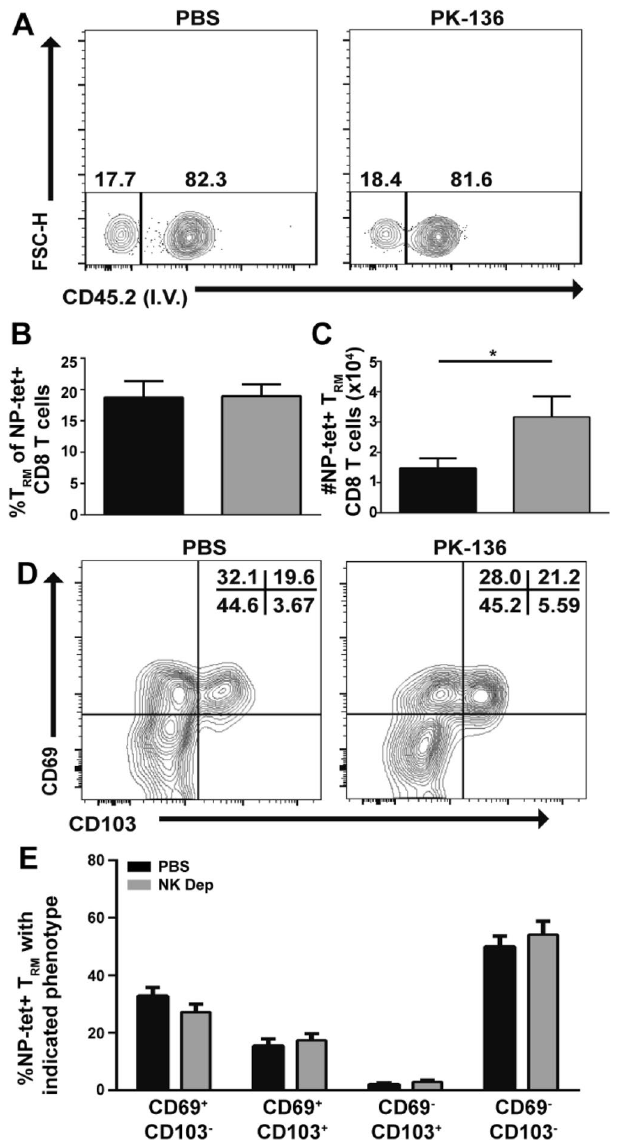
Figure 2. NK depletion enhances the development of lung T RM following influenza infection. (A) C57BL/6 mice were infected with 10 3 PFU x31, administered anti-NK depleting antibody at −1, 1, and 3 dpi and rested for 45 days. T RM were identified as cells which did not positively stain with an anti-CD45 administered i.v. 3 min prior to euthanasia, previously gated on single cells, lymphocytes, CD8 + CD44 + NP-tet + cells. The frequency (B), and number (C) of NP-tet + T RM CD8 + T cells ± SEM recovered from the lung of NK depleted (grey) and sufficient (black) mice are depicted. (D) Representative expression of CD103 and CD69 by lung T RM cells. (E) Frequency of cells expressing CD103 or CD69 in NK-depleted (grey) or sufficient (black) mice. Graphs represent pooled data from 2 independent experiments using n ≥ 3 mice/group/time point (total of 6 mice per group/time point). *p < 0.05; unpaired Student’s t-test with Holm-Sidak multiple comparisons